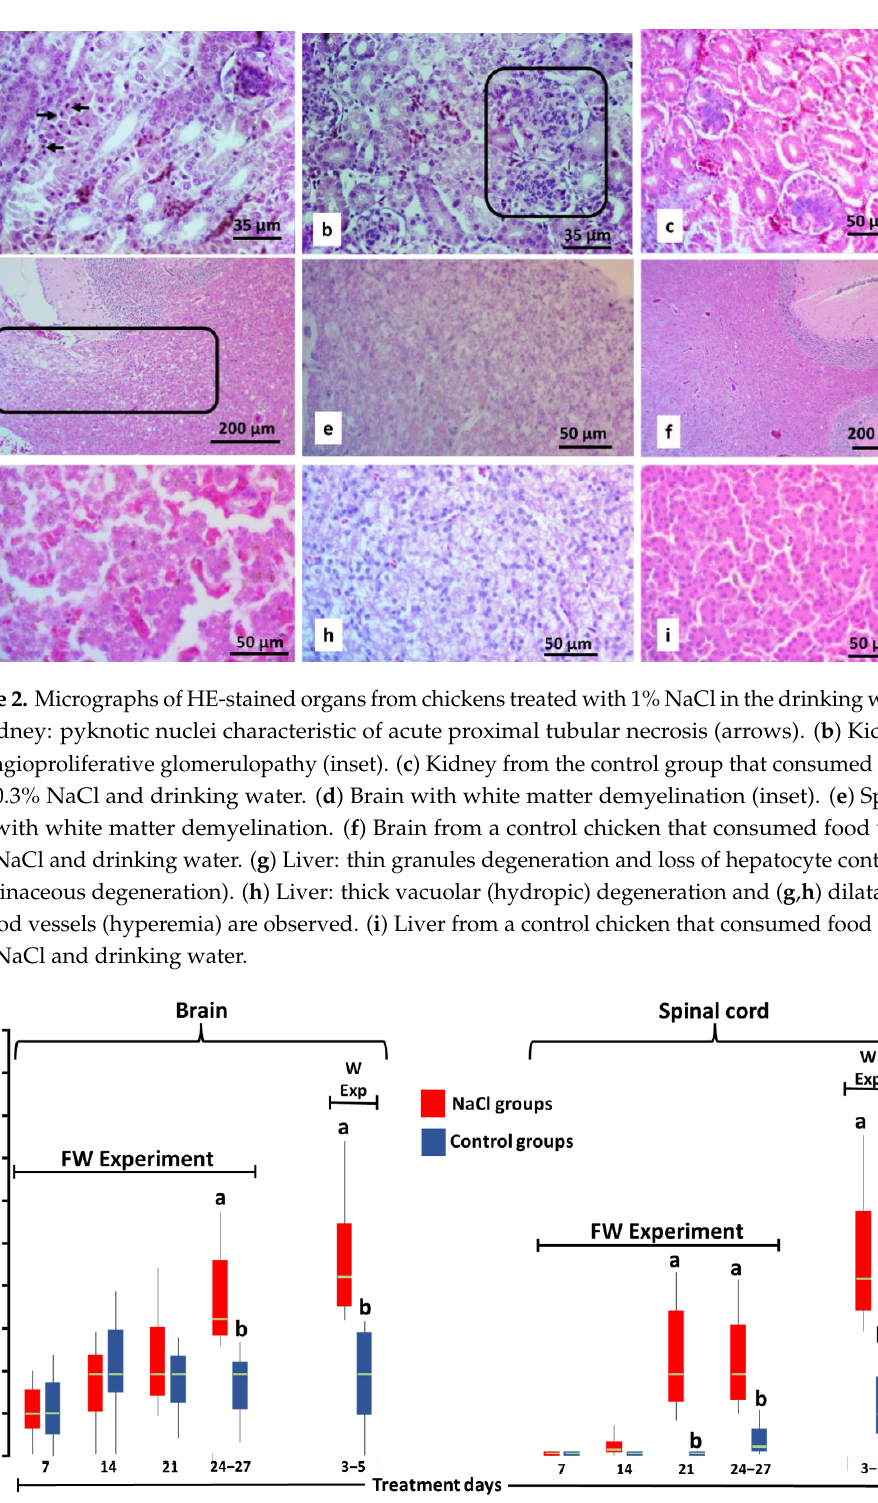
Figure 3. Score of axon demyelination of the brain and spinal cord neurons of SPF Leghorn chickens at 27 days of treatment with 3.3% NaCl in food and 5 days with 1% NaCl in drinking water (FW experiment) or at 5 days of treatment with 1% NaCl in drinking water (W experiment). Different letters above boxes for the same experiment and day denote significant differences ( p < 0.05). Green line: